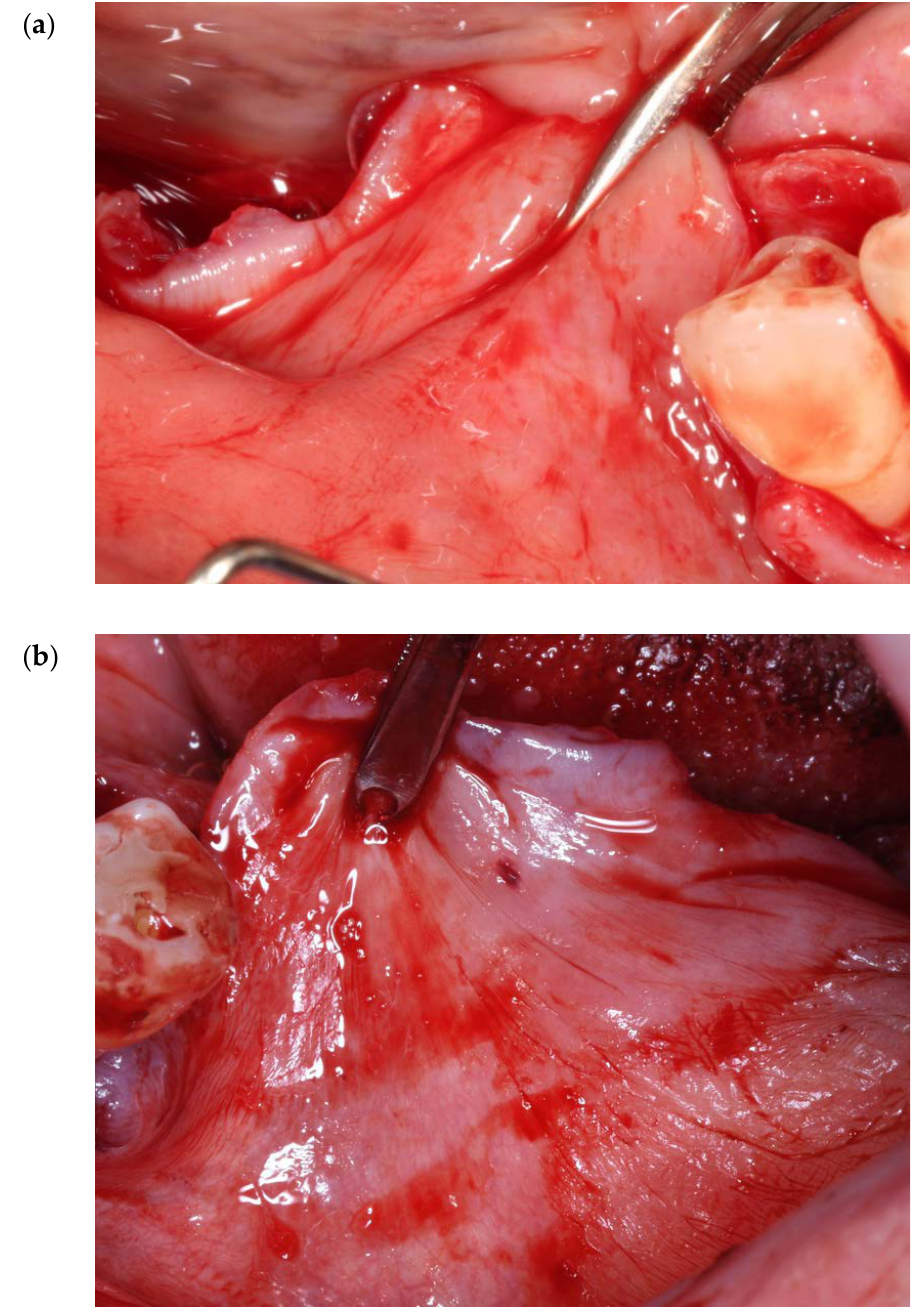
Figure 2. ( a , b ) Ten (10) mm of buccal periosteal release in a horizontal Figure 2 . ( a , b ) Ten (10) mm of buccal periosteal release in a horizontal direction.